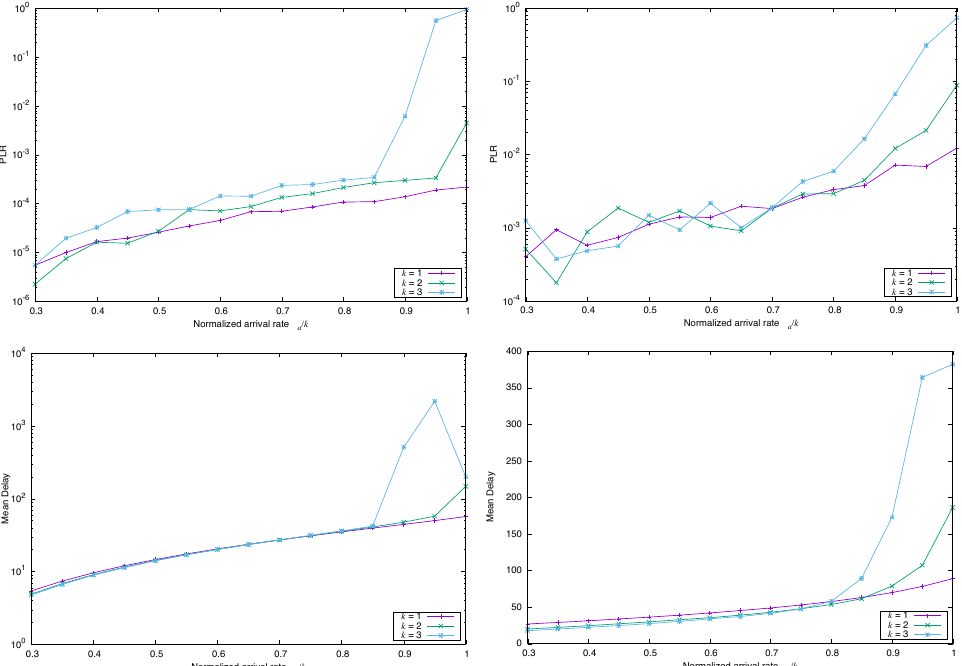
Figure 11. Simulated PLR ( top ) and Mean Delay ( bottom ) for FA-CSA versus λ a / k , with Λ ( x ) = 0.86 x 3 + 0.14 x 8 , n = 200 and k = { 1,2,3 } , and marginal distribution Pareto, with σ 2 = 1.1 µ 2 ( left ) and σ 2 = 4 µ 2 ( right